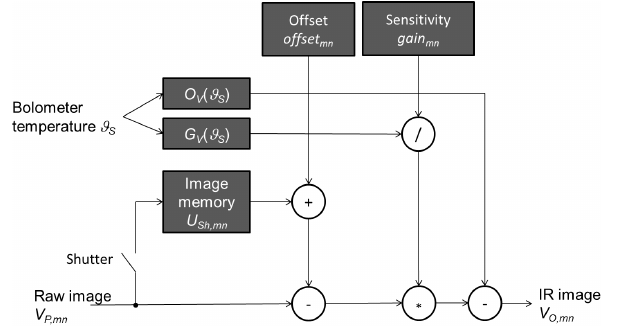
Figure 4. Extension of the camera model from Fig. 3 for the calcu- lation of the IR image for TEC-less